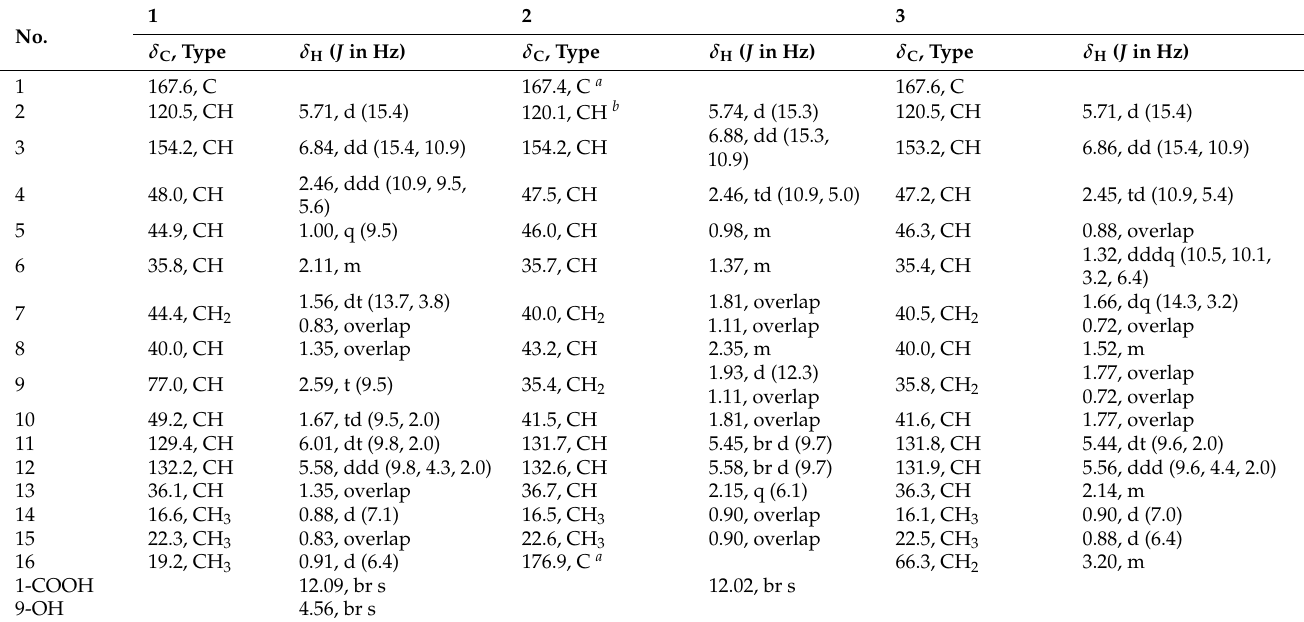
Table 1. 1 H and 13 C NMR data of compounds 1 – 3 in DMSO- d 6 .